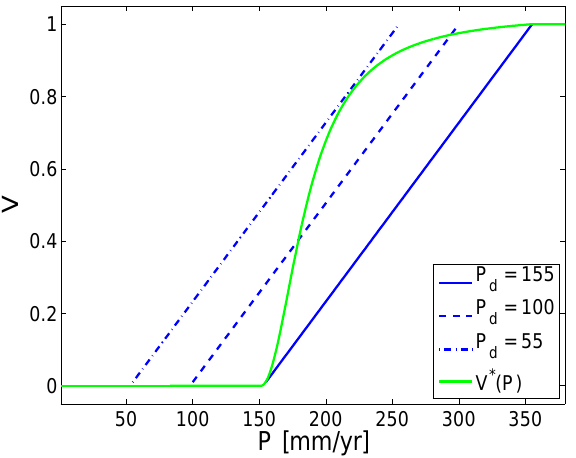
Fig. 2. Mean vegetation cover fractions (trees+grass) in % in the transient PlaSim-VECODE experiment from 9k to 2k. Vegetation cover is averaged over 200yr starting from the indicated year (7k, 6k, 5k, and 3k, respectively). Numbers 1 to 5 denote the individual grid cells referred to in the text. The red region encloses the 52 grid cells considered in RM1, the purple region encloses the 8 grid cells considered in